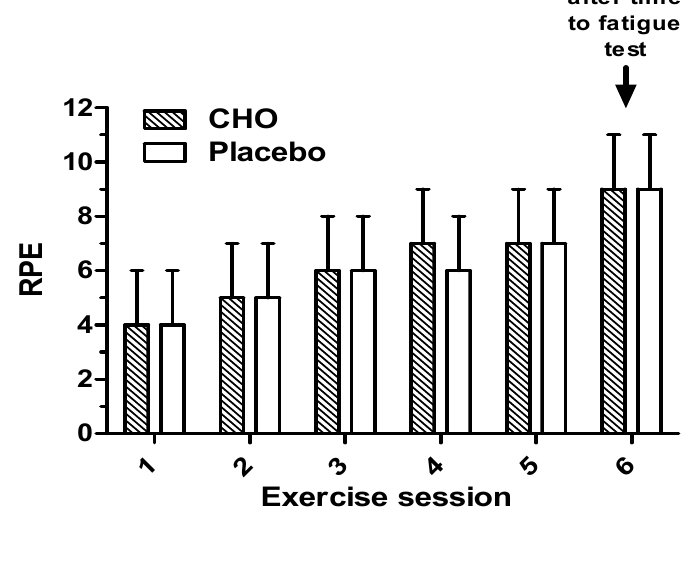
Figure 2. Changes in RPE during the simulated soccer match while ingesting the placebo (0% CHO) and 7% CHO solutions.